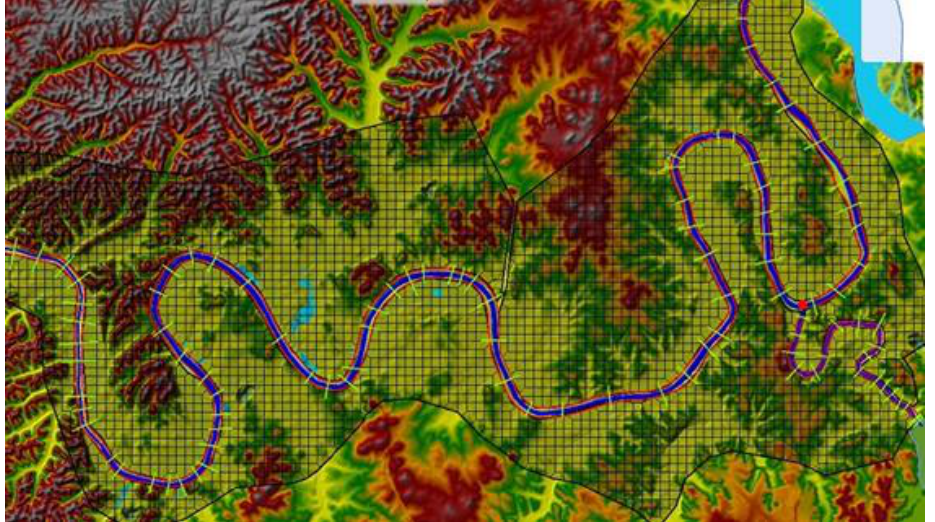
Figure 10. Optimized inundation area (shown in blue) using combined one- and two-dimensional approach in HEC-RAS for the May 2010 flood event.